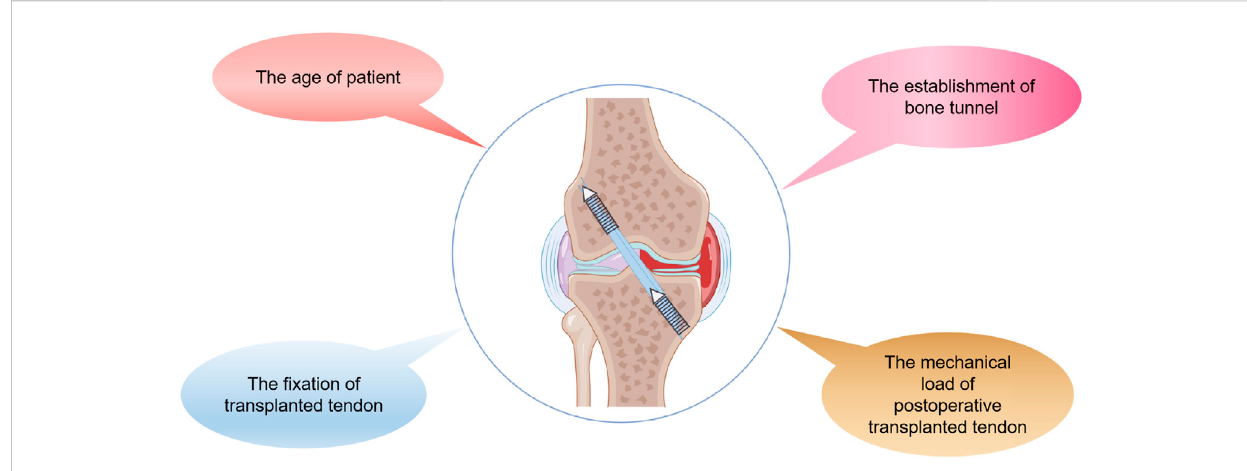
FIGURE 2 Themainfactorsthatmayaffecttendon-bonehealingafterACLreconstructionarepresentedbyFigdraw,includingtheageofpatient,the fi xationof the transplanted tendon, the establishment of the bone tunnel and the mechanical load of the postoperative transplanted